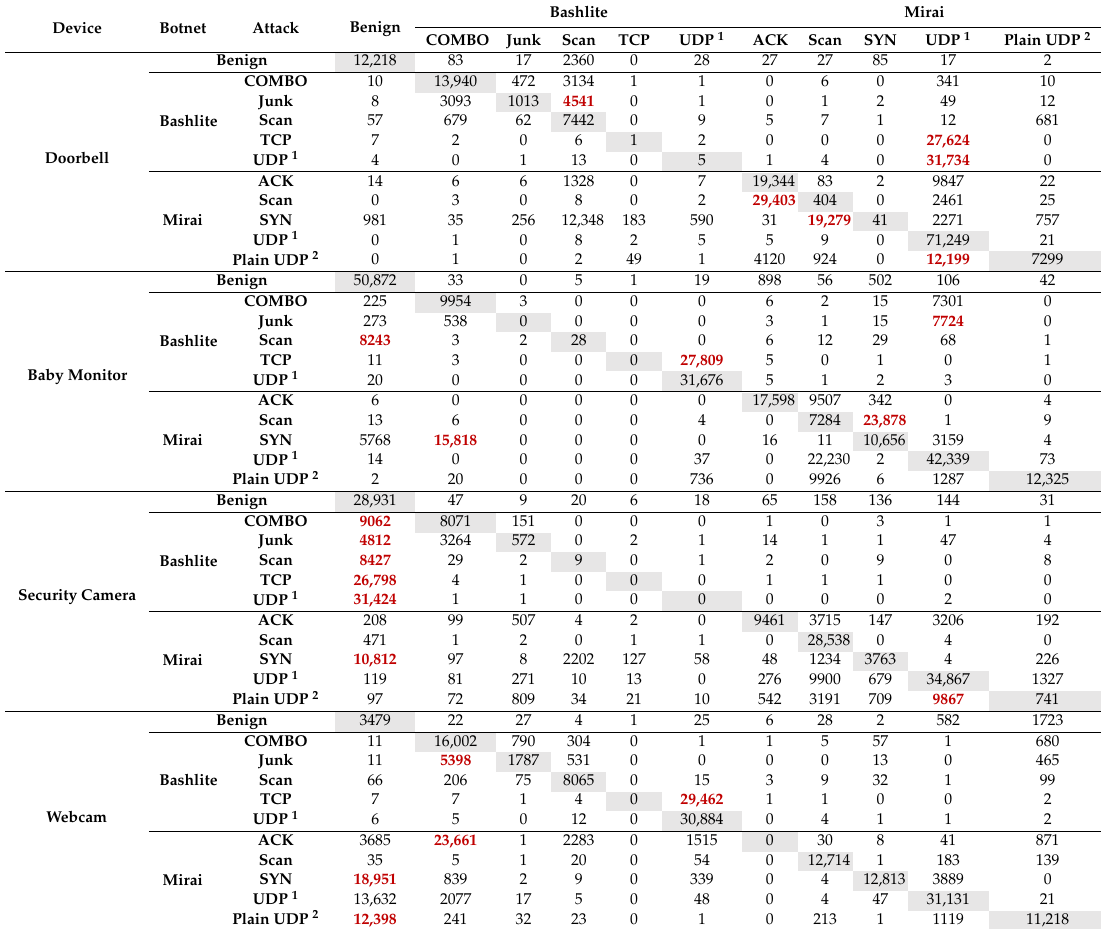
Table 15. F1-score of each specific attack for the